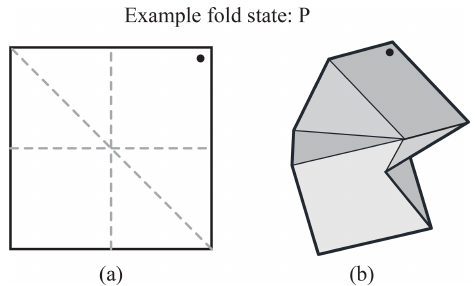
Figure 13. A crease pattern (a) with fold-angle assignment that will result in a fully fold state (b) . The legend for fold-angle assignment is given in Fig. 8. The fully folded state is often used for transporta- tion or storage, as seen in Fig.